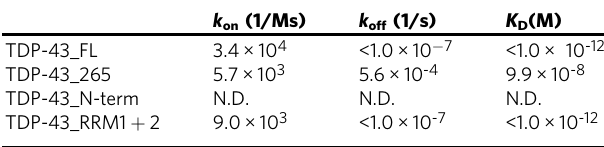
N.D.: unable to be determined due to absence of signi fi cant binding